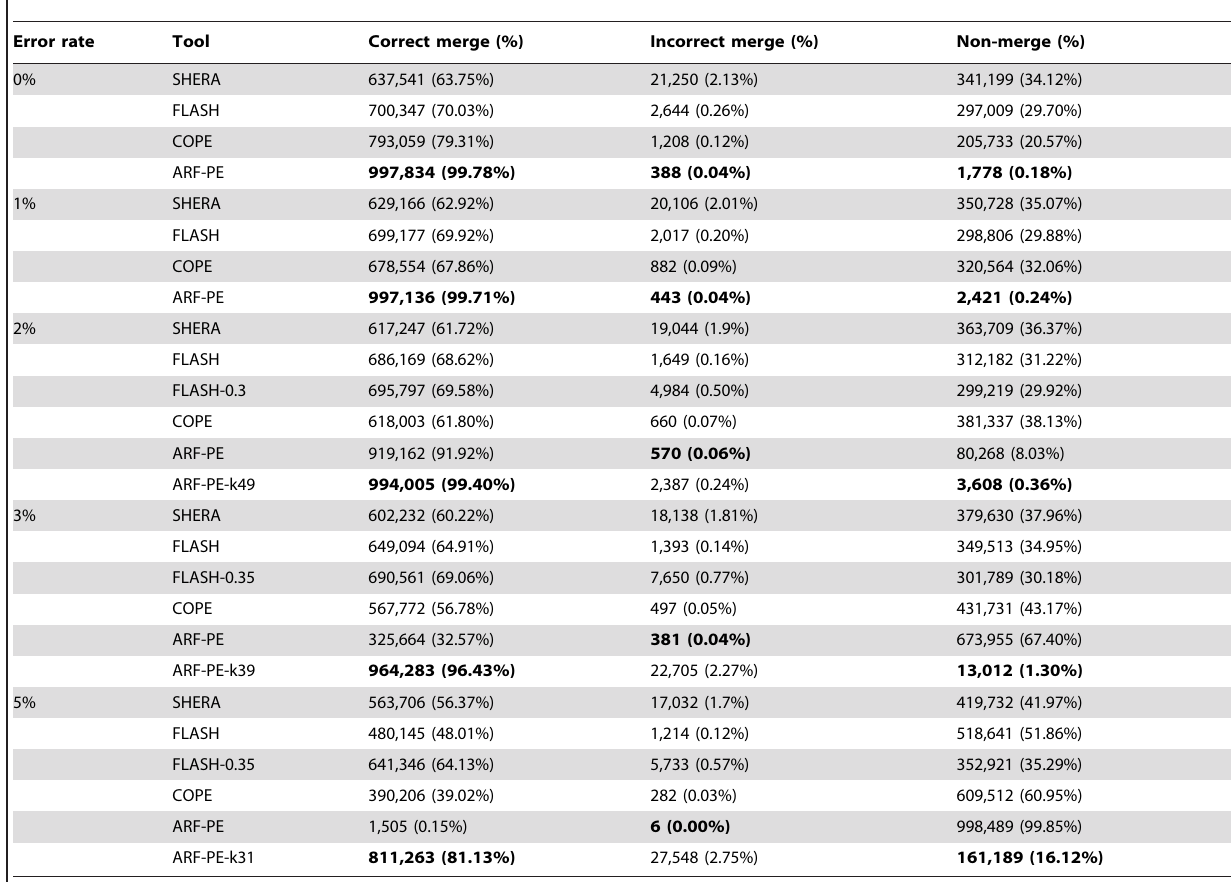
Table 2. Performance of SHERA, FLASH, COPE, and ARF-PE on merging paired reads.